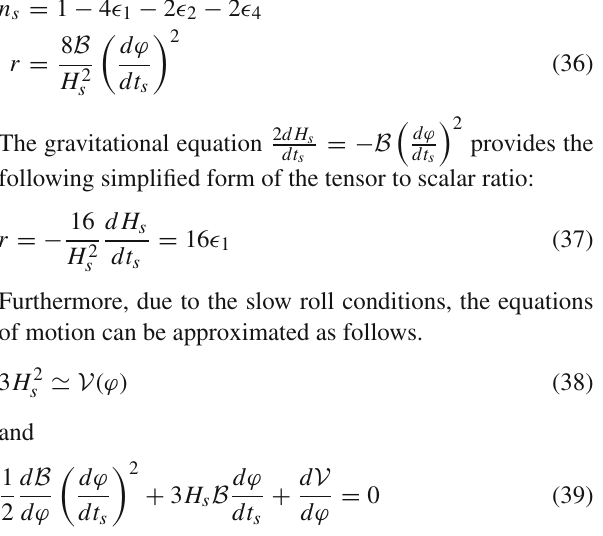
then the associated scalar-tensor model’s metric changes to −√ 2 / 3 (cid:15)(ϕ) a 2 (η) [− d η 2 + δ μν dx μ dx ν ] d ˜ s 2 = e In the scalar-tensor model, a s (η) = e